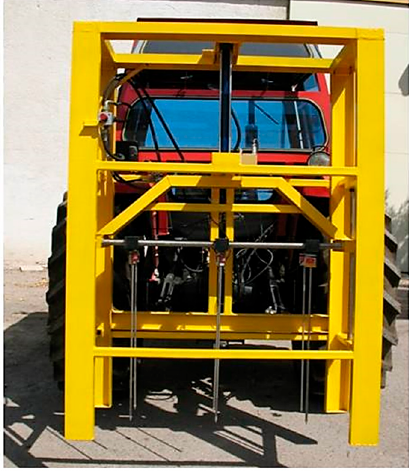
Figure 4. Tractor-mounted soil cone penetrometer for measuring the soil cone index.